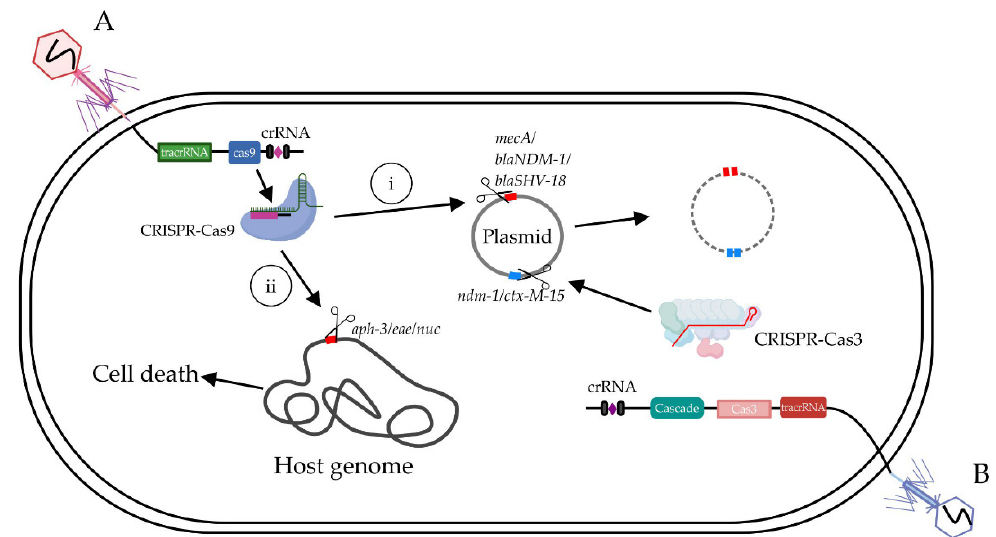
Figure 2. The CRISPR-Cas system including tracrRNA (trans-activating crRNA), Cas9 protein and crRNA (CRISPR RNA) delivered by engineered phages against antibiotic-resistant bacteria. ( A ) Phage-delivered CRISPR-Cas9 could lead to cell death and plasmid loss by targeting genes on the (i) chromosome ( aph-3 / eae / nuc ) and (ii) plasmid ( mecA / blaNDM-1 / blaSHV-18 ), respectively [16,17,24]. ( B ) Phage-delivered CRISPR-Cas3 targets specific DNA sequences ( ndm-1 / ctx-M-15 ) in plasmid [23] .